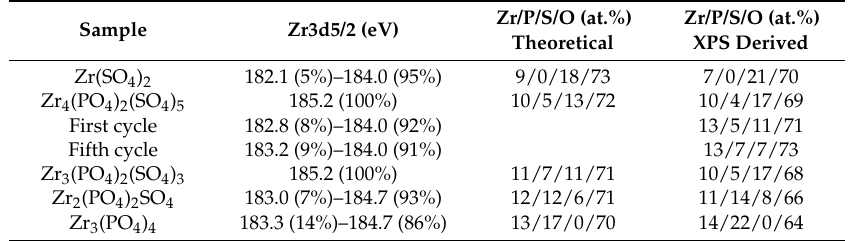
Figure 6. P2p, S2p and Zr3d XPS region of Zr 4 (PO 4 ) 2 (SO 4 ) 5 fresh and after five catalytic cycles.